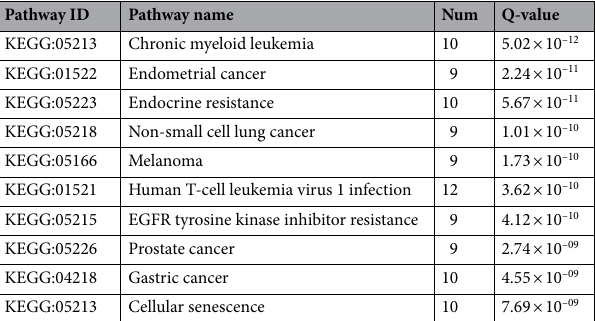
Table 3. Ten most enriched KEGG pathways. Q-value is computed by using g:SCS multiple testing correction method. Abbreviation: Num, Number of genes involving in the